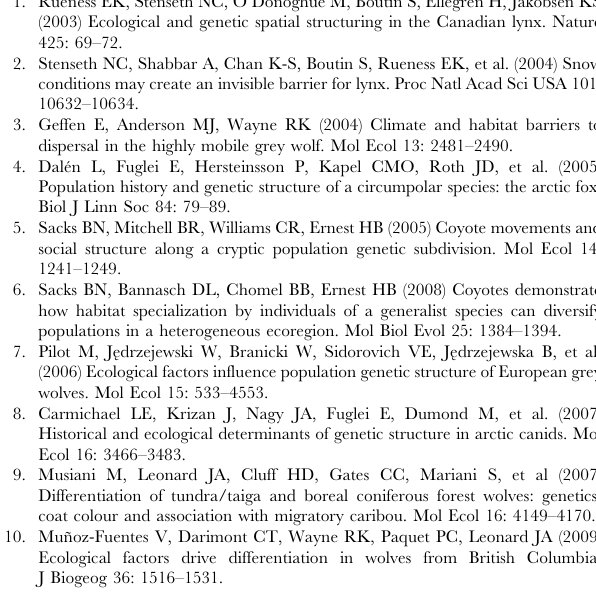
isotope profiles ( % ) for wolf prey species analyzed in this study. Table S3 Diet composition of wolves inferred from the stable isotope data using MixSIR. For: (A) four subpopula- tions delimited based on mtDNA variability (MIT 1- MIT 4), (B) two subpopulations delimited based on microsatellite variability (NUC 1, NUC 2), and (C) all individuals pulled together. The result for the subpopulation MIT 4 is based on one individual only and therefore is biased. We report median and 25th–75th percentile (25 and 75%ile) ranges. Because in some cases the posterior distributions are multimodal, these percentiles may not adequately describe the posterior surface of the source contribu- tions. The posterior distributions are presented in the Figure S1. Table S4 Effects of ecological factors and geographical distance on genetic differentiation of Eastern European wolves. The tests were performed in the same way as those presented in Table for, but additional explanatory variables were considered. For details see Table 4 legend and Methods section with the description of the